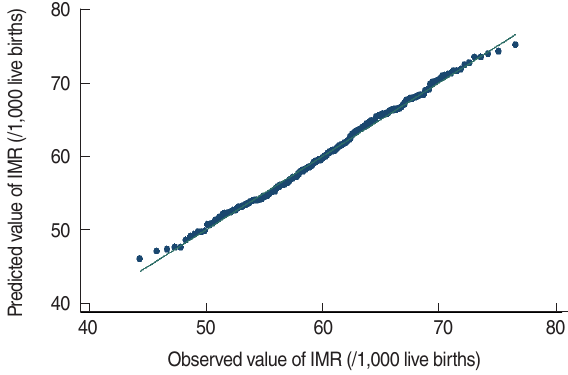
Figure 3. Plot of observed against the fitted infant mortality rate (IMR)